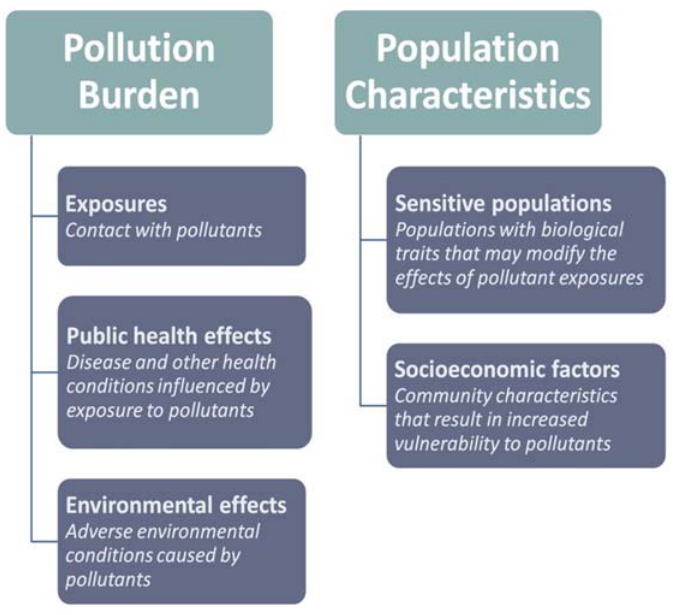
Figure 1. Components of cumulative impact and their